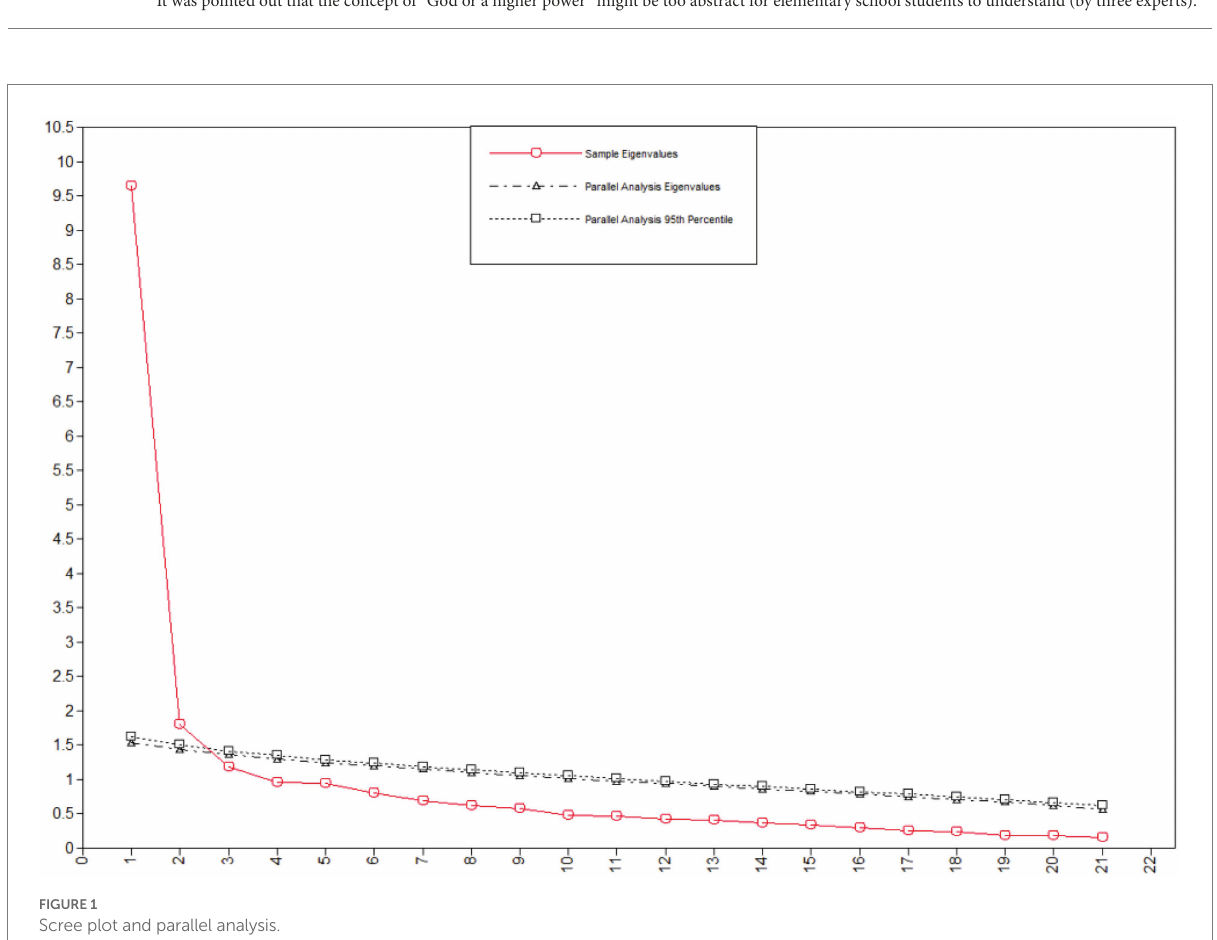
Table 3. The model fit statistics of the hierarchical second-order model showed an appropriate fit: comparative fit index (CFI) = 0.98, Tucker–Lewis index (TLI) = 0.98, root mean square error of approximation (RMSEA) = 0.07.